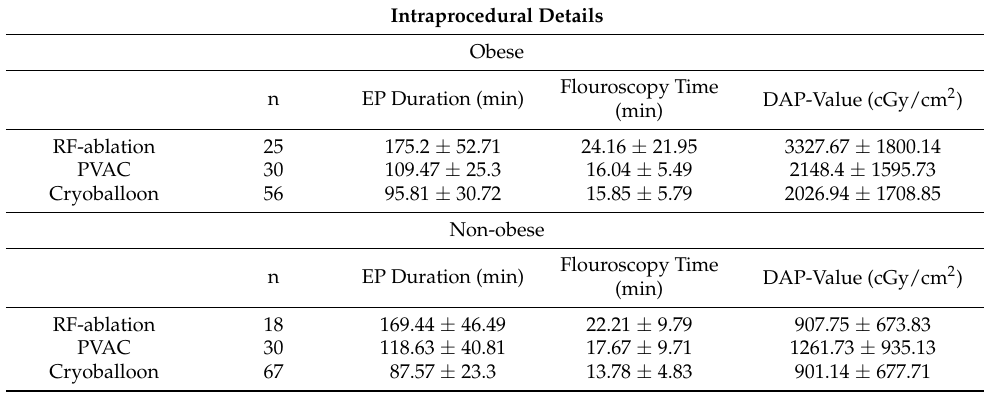
Table 3. Intraprocedural details regarding ablation technique and resulting EP